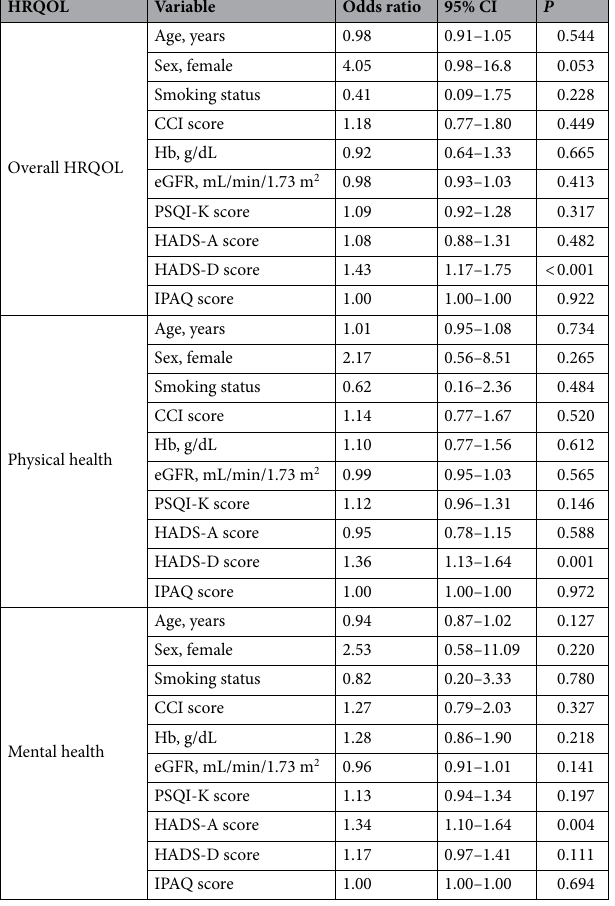
Table 3. Determinants of low health-related quality of life (HRQOL) among patients with diabetic kidney disease by multivariable logistic regression analyses. Low HRQOL was defined as an SF-36 score > one SD below the mean. Low physical health and low mental health were defined as PCS scores and MCS scores > one SD below the mean, respectively. CCI Charlson Comorbidity Index, eGFR estimated glomerular filtration rate, IPAQ International Physical Activity Questionnaire, HADS-A Hospital Anxiety and Depression Scale-anxiety subscale, HADS-D Hospital Anxiety and Depression scale-depression subscale, Hb hemoglobin, HRQOL health-related quality of life, MCS mental component summary, PCS physical component summary, PSQI-K Korean version of the Pittsburgh Sleep Quality Index, SF-36 Short Form 36 Health Survey